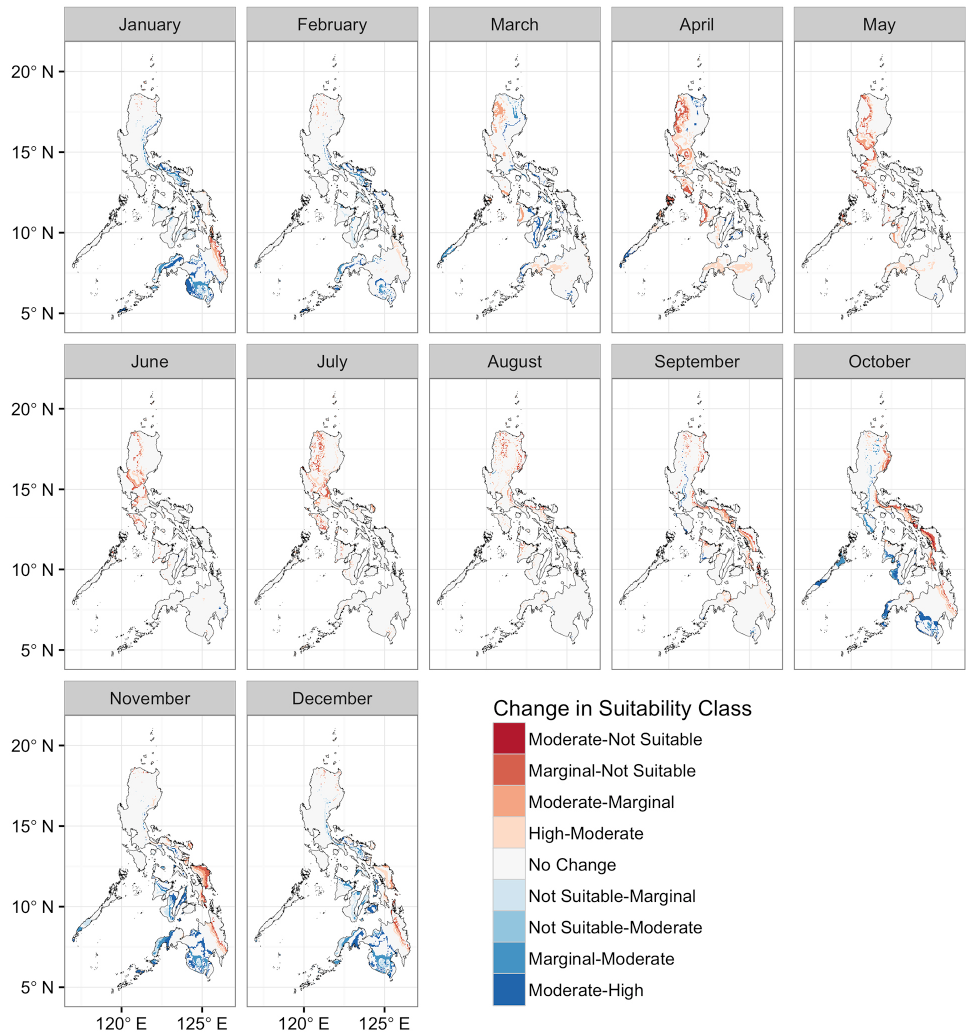
Fig. 9. Monthly spatial distribution of changes in climatic suitability of corn based on rainfall in the Philippines under future climate